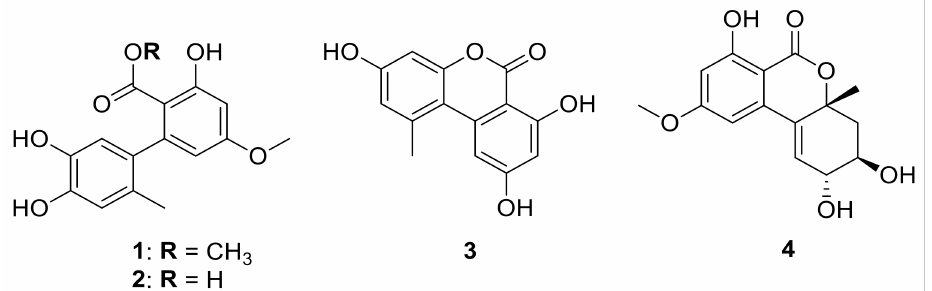
Figure 1. Structure of isolated compounds ( 1 – 4